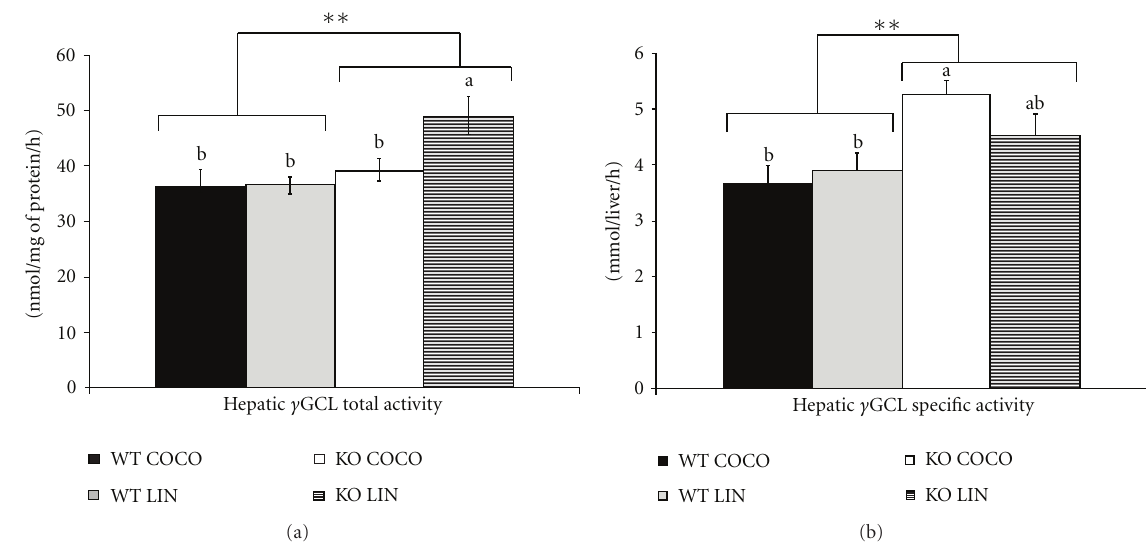
Figure 1: Hepatic GCL activity in WT and PPAR α -deficient (KO) mice fed diets containing either saturated FA (COCO diet) or ALA (LIN diet) for 8 weeks. Values are expressed as nmol/mg of protein/h for specific activity (a) and as mmol/liver/h for total activity (b). They are means ± standard errors for 7 mice per group, ∗∗ KO group significantly di ff erent from WT group P < 0.01. Columns sharing a same superscript letter, or without superscript letter, were not significantly di ff erent at P <